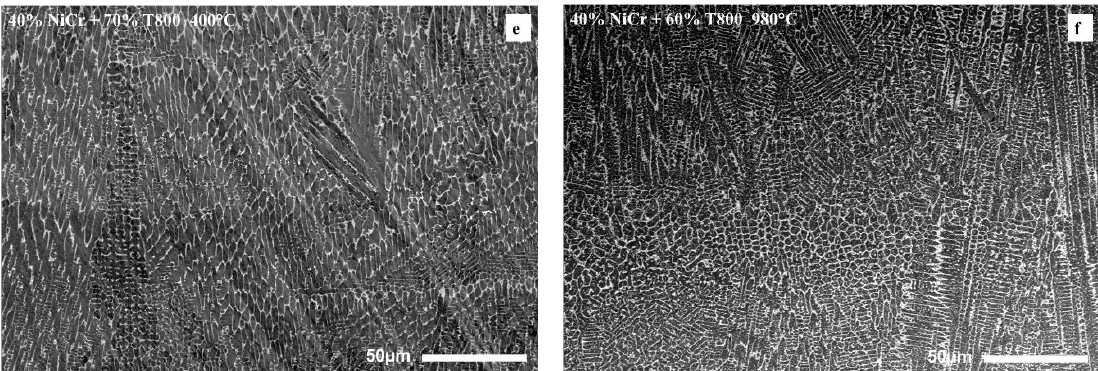
Figure 6. SEM microstructure results of heat treated (HT) samples. T800 + 20% NiCr: ( a ) HT at 400 °C and ( b ) HT at 980 °C. T800 + 30% NiCr: ( c ) HT at 400 °C and ( d ) HT at 980 °C. T800 + 40% NiCr: ( e ) HT at 400 °C and ( f ) HT at 980 °C.